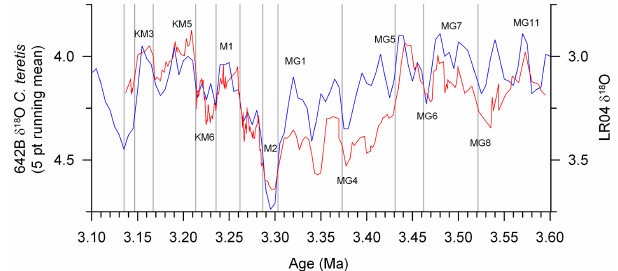
Figure 3. For the investigated time interval the age model of ODP Hole 642B is based on correlating the 5-point smoothed benthic δ 18 O from 642B (Risebrobakken et al., 2016) with the global ben- thic oxygen isotope stack, LR04 (Lisiecki and Raymo, 2005). The LR04 stack is shown in blue and the smoothed 642B Cassidulina teretis δ 18 O record is shown in red. The grey vertical lines indi- cate the tie points defined by the correlation and were used when calculating the ages of Hole 642B. Indicated isotope stages refer to isotope stages as defined by Lisiecki and Raymo